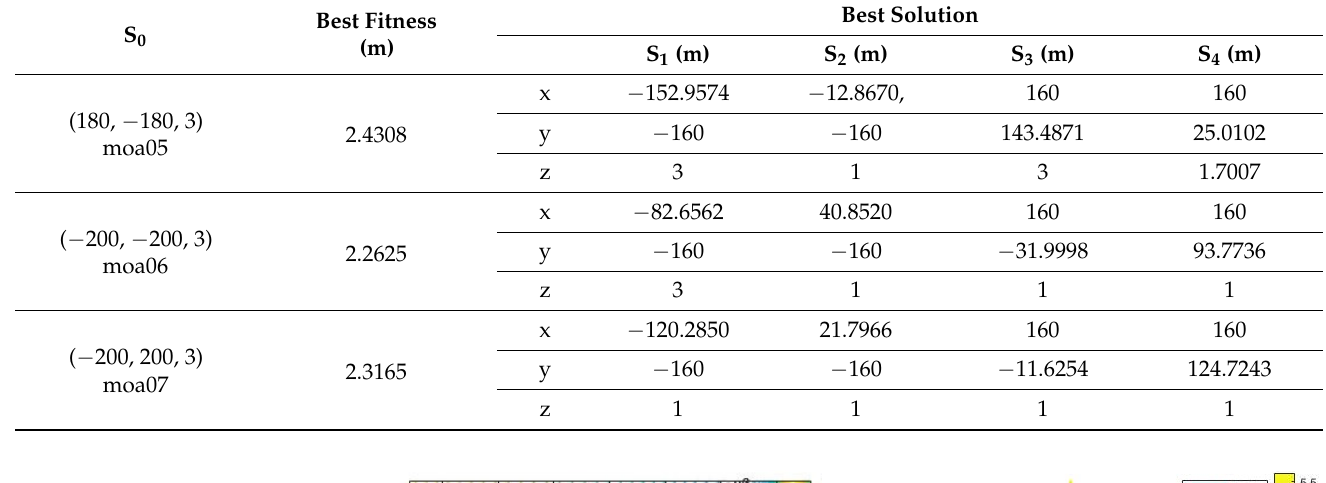
Table 3. Optimized results of the five station deployments.